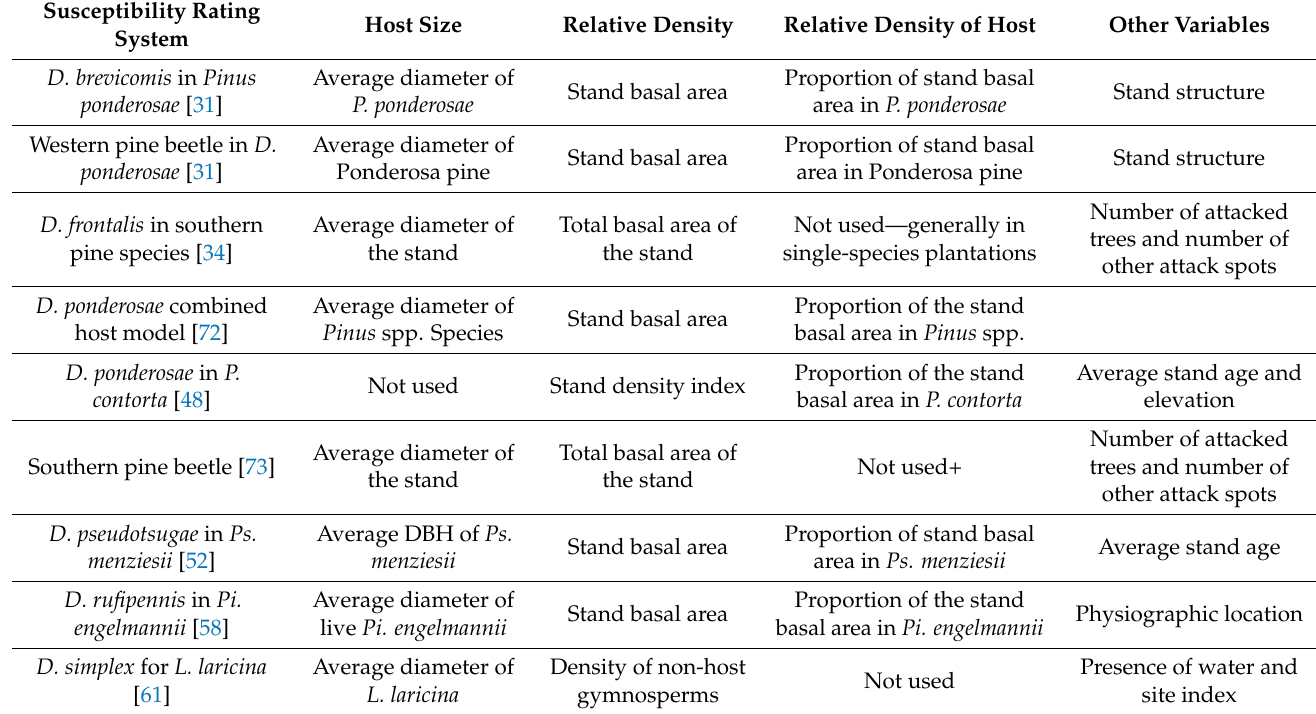
Table 2. Characteristics shared by several susceptibility rating systems for an individual Dendroctonus species and associated tree species. Note the use of the term susceptibility to include risk and